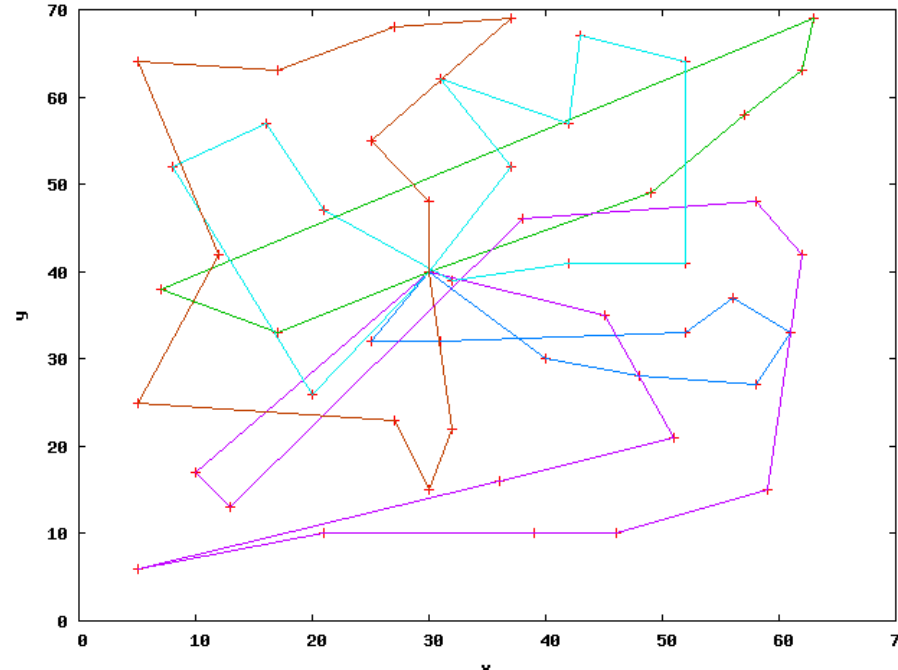
Figure 6. All combinations, moderate settings, fast experiment—example with fitness close to